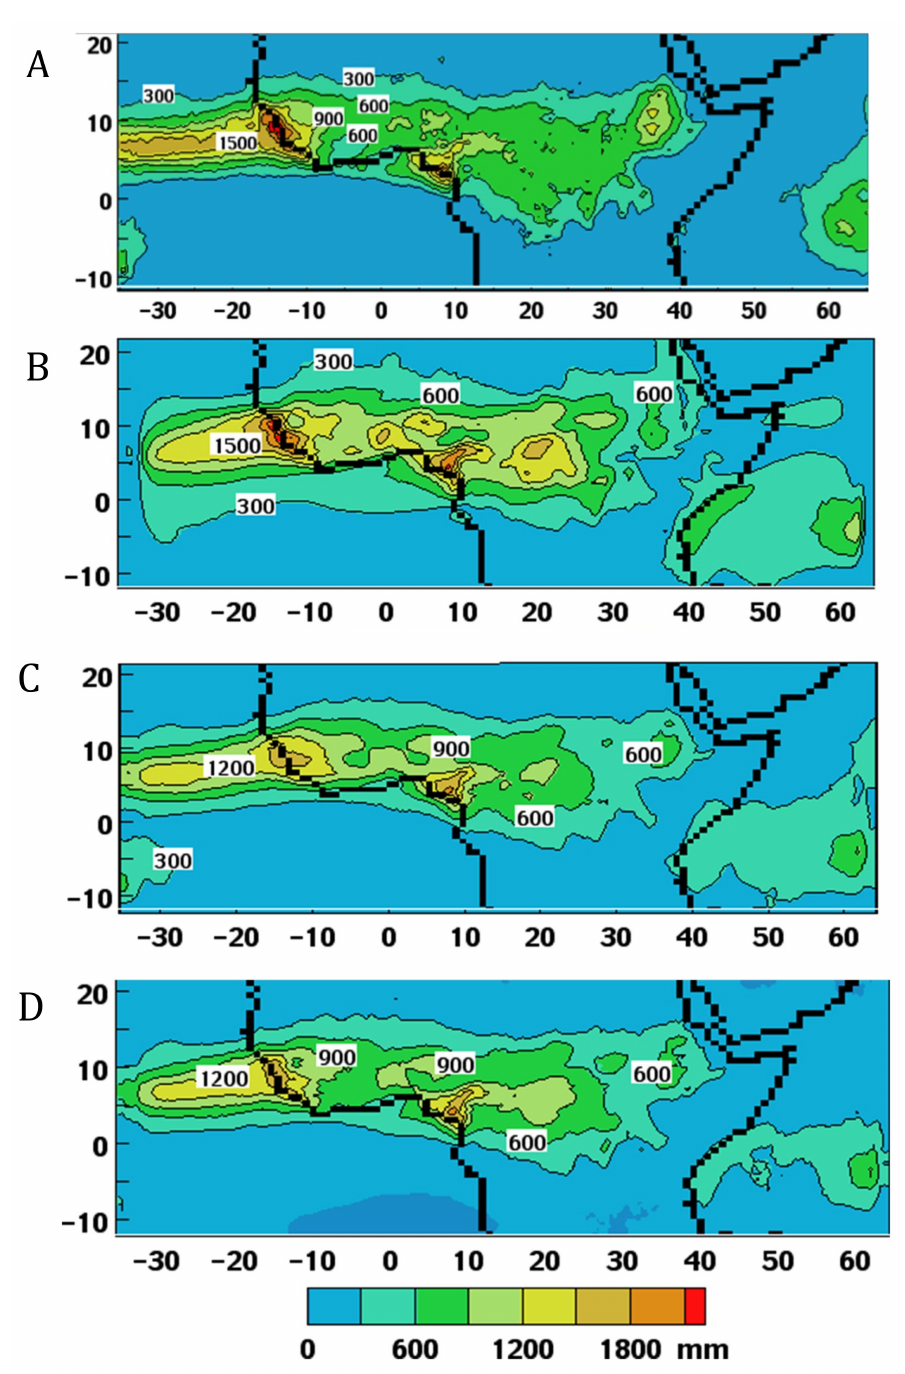
Figure 1. June–September precipitation accumulations (mm), averaged over 1998–2002: ( A ) Tropical Rainfall Measuring Mission (TRMM); ( B ) RM3nc forced by ModelE without bias corrections; ( C ) RM3bc forced by ModelE with bias corrections to LBCs and sea-surface temperature (SST); ( D ) RM3sst forced by ModelE with bias corrections to only